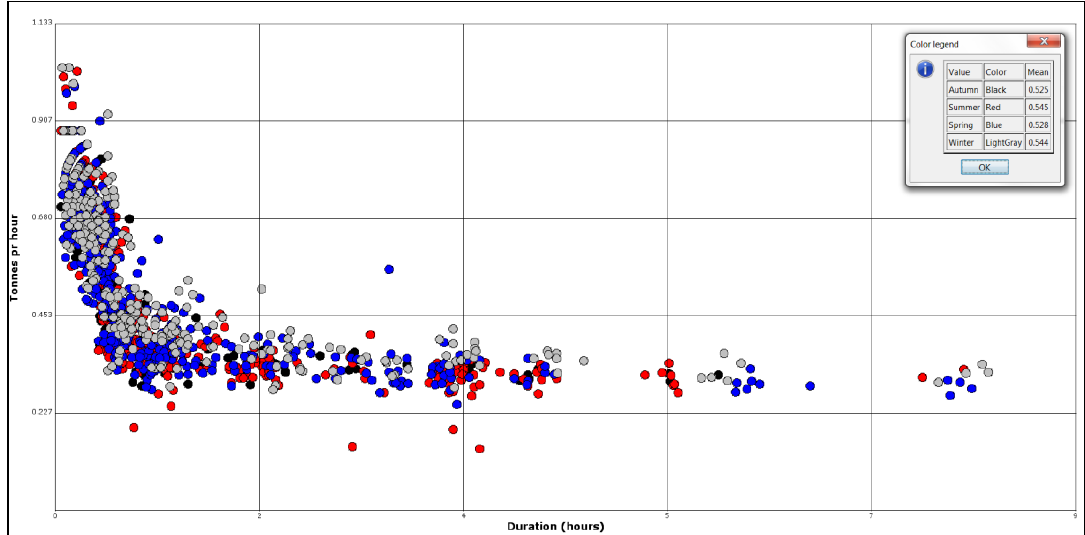
Figure 3. Fuel consumption in port, MS Finnmarken . Table 5. Energy consumption and specific fuel consumption for Finnmarken.